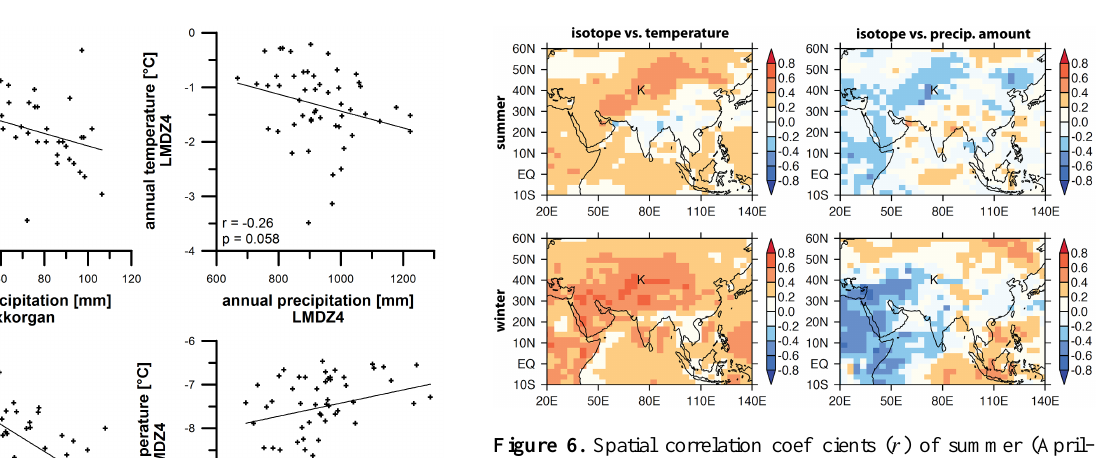
Figure 6. Spatial correlation coefficients ( r ) of summer (April– September) and winter (October–March) δ 18 O precip at the Karakuli site (marked as K in the plots) with temperatures and precipitation amounts at each grid point from 1958 to 2009 (LMDZ4 simulations; Lee et al.,